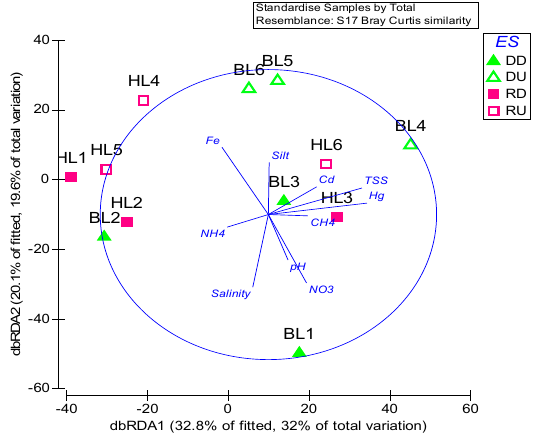
Figure 7. The dbRDA plot on the correlation between nematode generic composition on abundance with environment variables for all stations of estuarine sections. Abbreviations: (Es: estuarine-section), “DD” = dammed downstream, “DU” = dammed upstream, “RD” = reference downstream, “RU” = reference upstream.